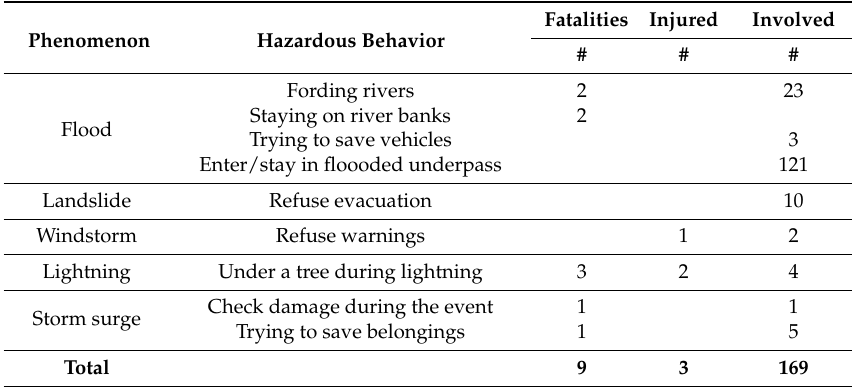
Table A4. Types of phenomena and hazardous